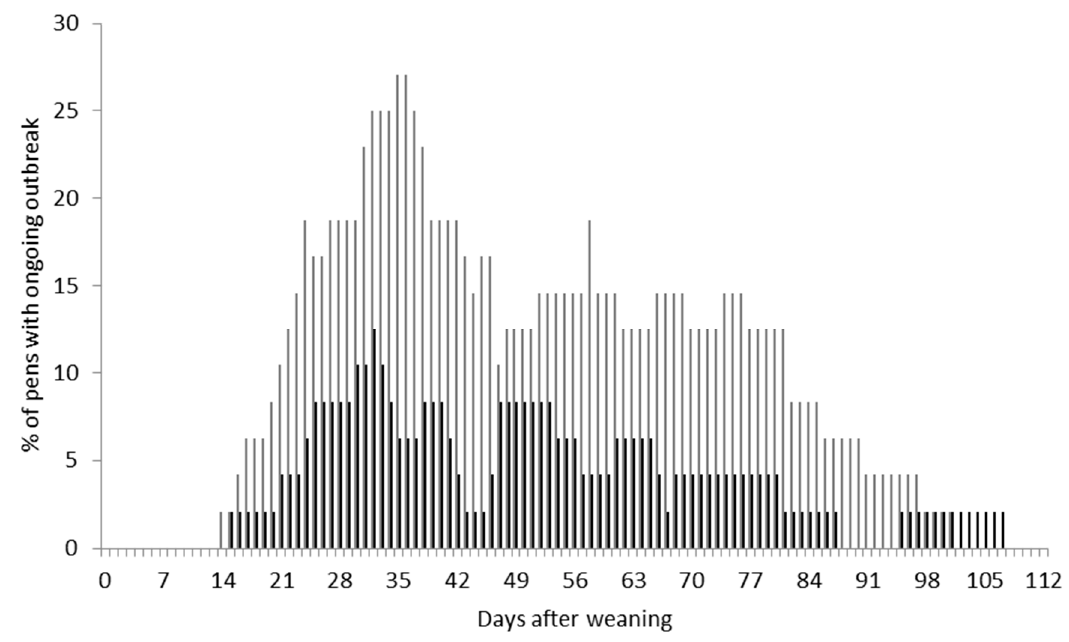
Figure 2. Percentage of pens with ongoing tail biting outbreaks (defined as being between the criteria for the start of an outbreak and successful resolution, criteria for each of these are explained in the text) plotted against days post-weaning within trial 1 (light grey) and trial 2 (black).